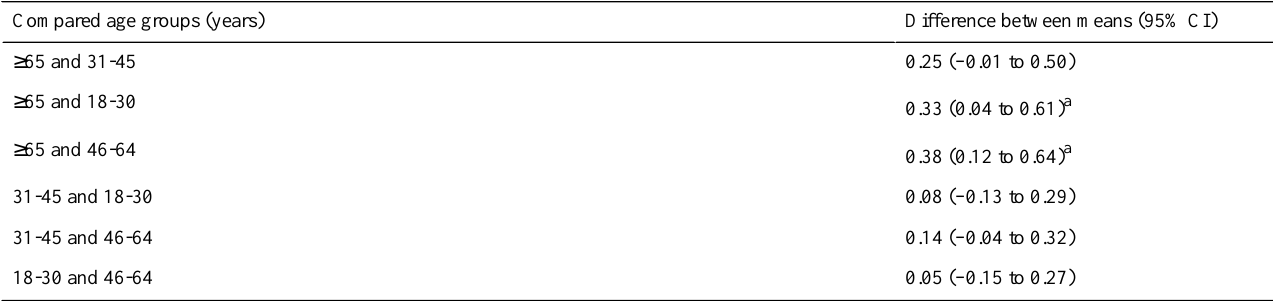
Table 3. Results of the Tukey HSD test for differences between personal risk perception and age group (N=1054).